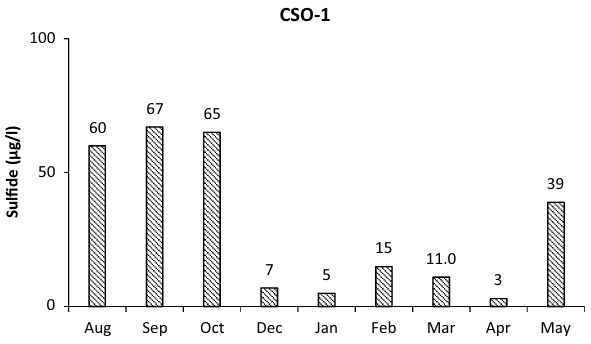
Fig. 9 Variation of sulfide (as S. 2− , µg/l) concentration at the sam- pling location close to CSO-1